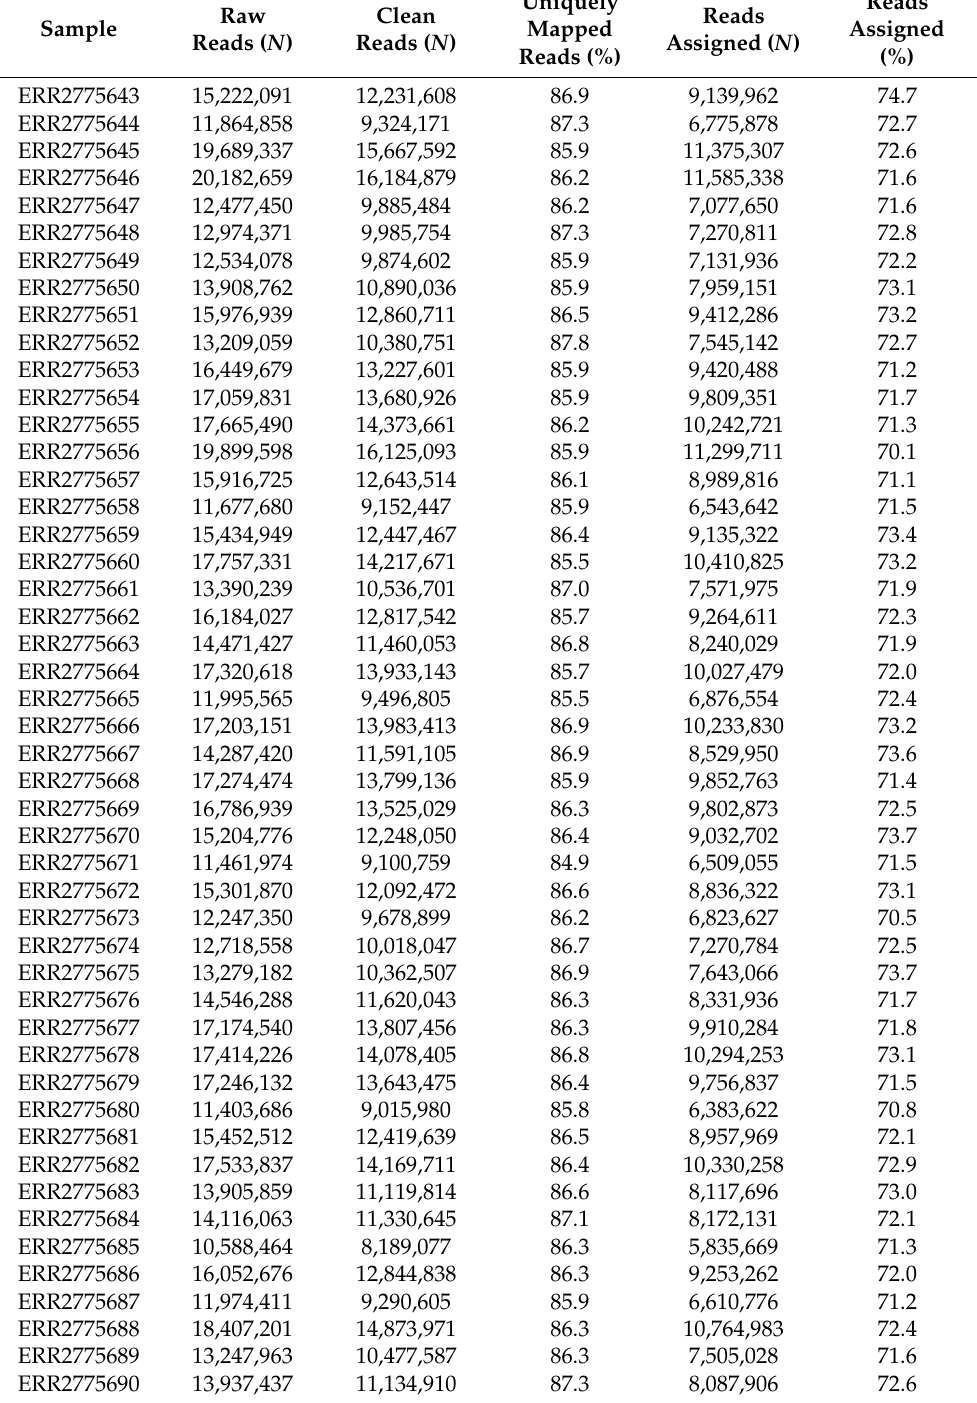
Table 1. Results of RNA-seq data pre-processing and gene expression analysis. The table shows, for each sample, the number of starting reads (raw reads), the number of reads remaining after the trimming step (clean reads), the percentage of reads out of the total clean reads uniquely mapped to the genome (uniquely mapped reads), and the number and percentage of reads assigned to exons out of the total clean reads for the identification of differential expression